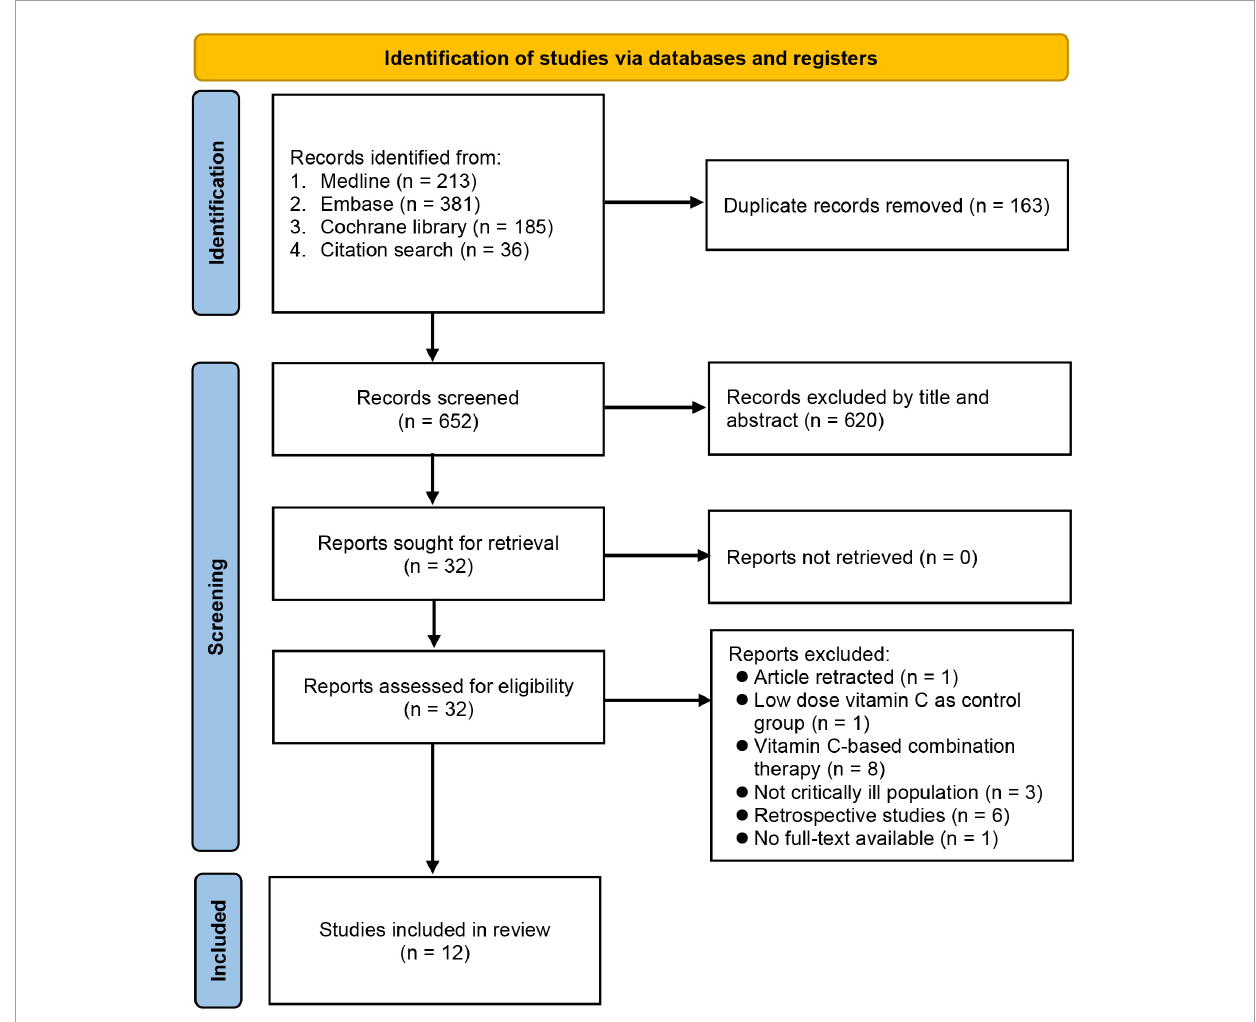
FIGURE1 PRISMA flow diagram of study selection for the current